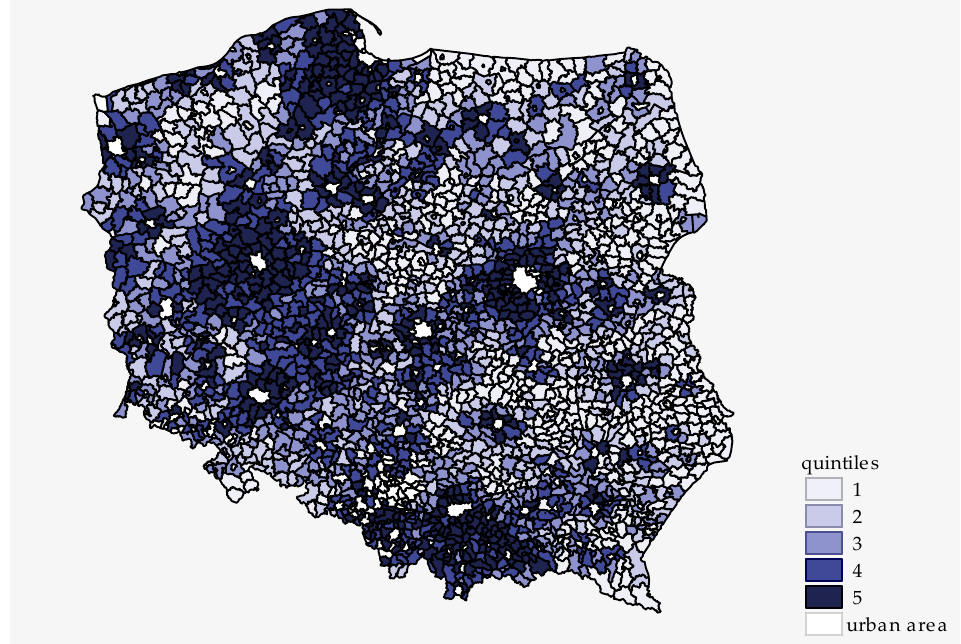
Human Capital in area of Labour Market [HCLM]. Synthetic measure [0,1].